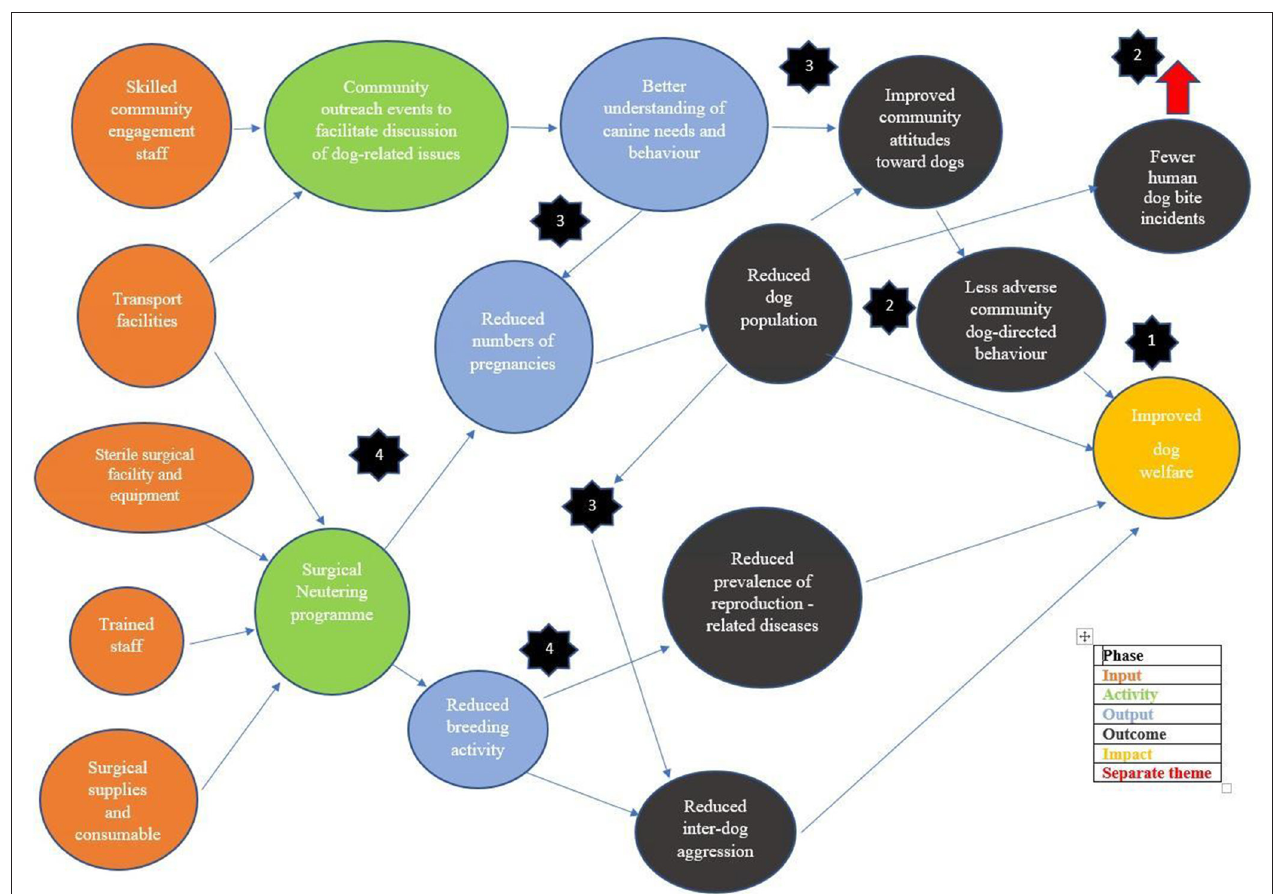
figure 3 | Process for Dogs Trust Worldwide Dog Population Management